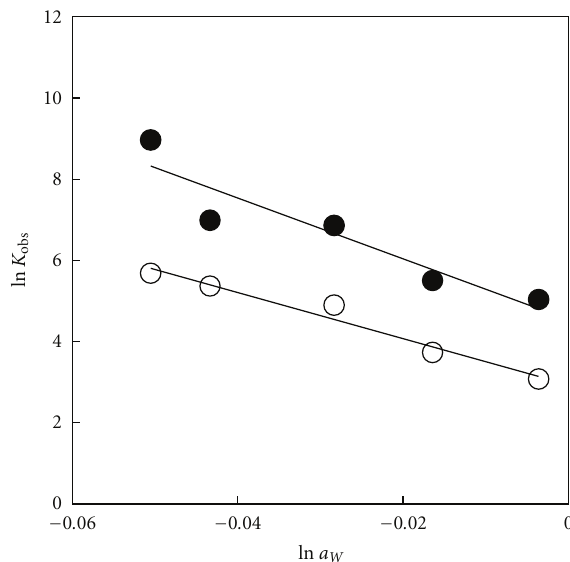
Figure 4: Plots of ln K obs versus ln a w for AP-0 (closed circle) and AP-1 (open circle) for the formationof the G-quadruplex in a bu ff er of 100mM NaCl, 50mM Tris-HCl (pH 7.0), and 1mM Na 2 EDTA containing 0 (0molL − 1 ), 10 (0.5molL − 1 ), 20 (1molL − 1 ), 30 (1.5molL − 1 ), or 40 (2molL − 1 ) wt% PEG200 at 37 ◦ C.